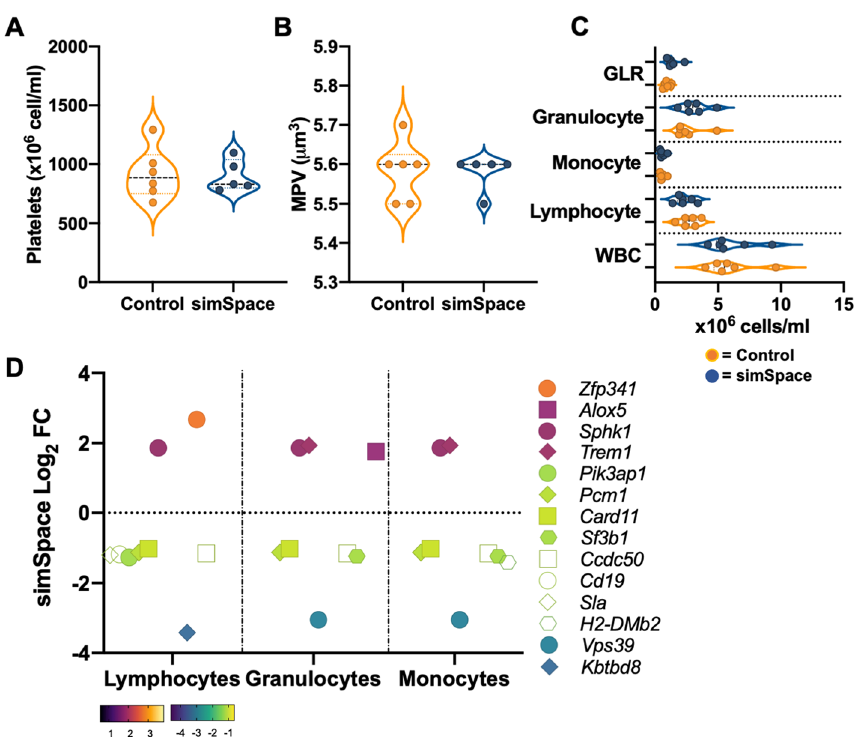
Figure 4. Splenic DEGs are altered post-simulated spaceflight, with minimal differences in immune population distributions in circulating blood. Whole blood was collected and platelets counts, × 10 3 per mm 3 ( A ) and MPV, mean platelet volume per cell, femtolitre (fL) ( B ) are displayed. ( C ) White blood cells (WBC), lymphocytes, monocytes, granulocytes, and granulocyte-to-lymphocyte ratio (GLR) are displayed for controls (orange) and simSpace (blue) conditions. ( D ) Significant upregulated and downregulated DEG (Log 2 fold change) are displayed for each WBC subtype. Cell numbers were normalized to controls. Data represents ± SEM, n = 6 per group. An unpaired, parametric t test with Welch’s correction was performed for ( A – C ), * p <